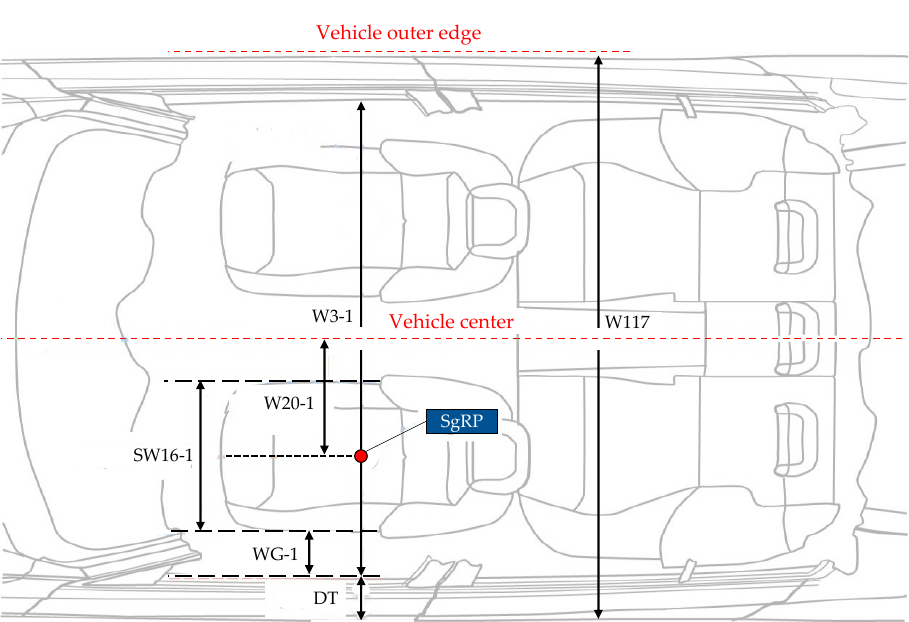
Figure 5. Overview of the dimensional chain in the Y-direction, based on [7, p. 597.]